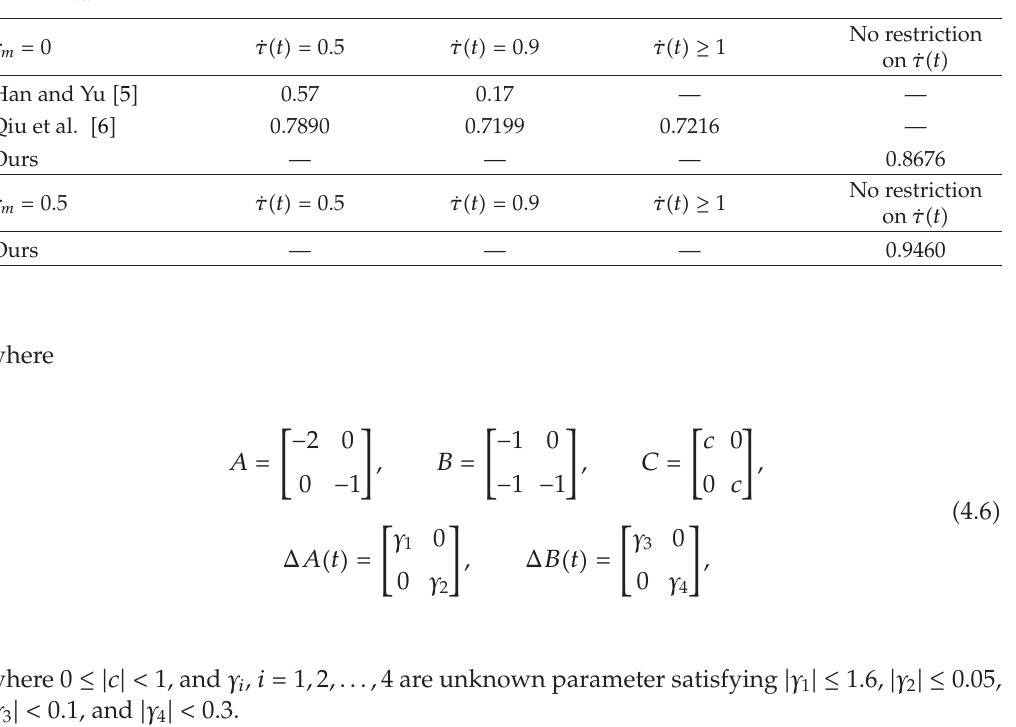
Table 4: Maximum allowable upper bounds τ M of the time-varying delay for di ff erent values of the lower bounds τ m , c (cid:9) 0 . 1 and δ (cid:9) 0 .